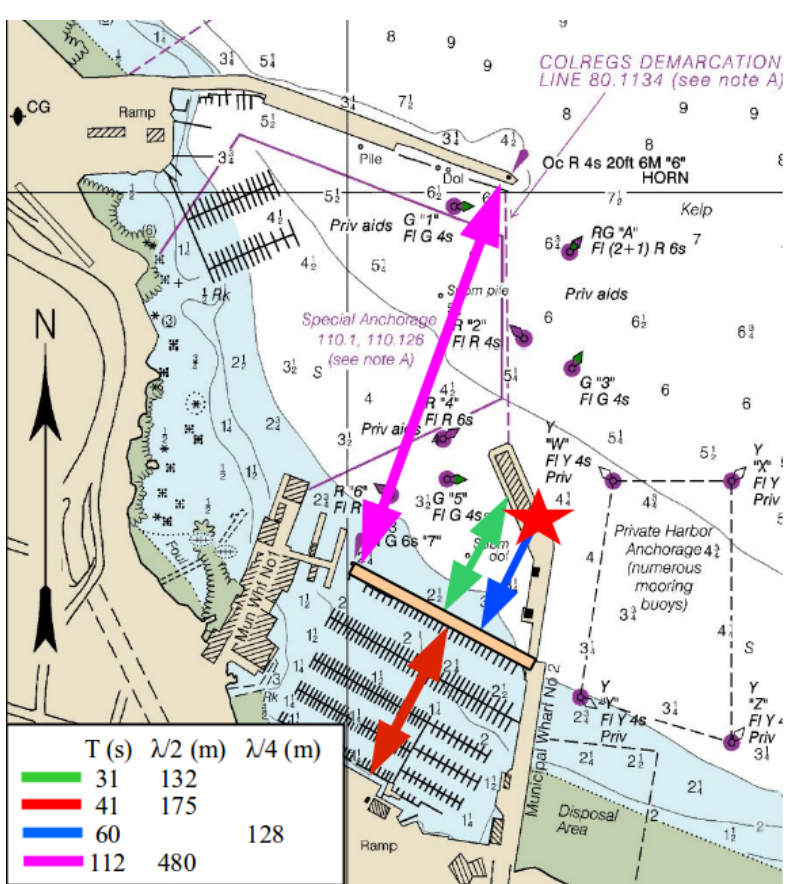
Figure 5. Chart of Monterey Harbor with resonant mode length scales corresponding to periods observed in the power spectra. The tide gauge location is denoted by the star. Wavelengths are determined from the general dispersion relation applied at a depth of 7.5m. Spatial scales of λ/ 2 are sustained between two reflective boundaries, while the fundamental length of λ/ 4 corresponds to one open boundary such as the tide gauge on the wharf and one reflective boundary. Chart is number 18685 from the NOAA National Ocean Service Coast